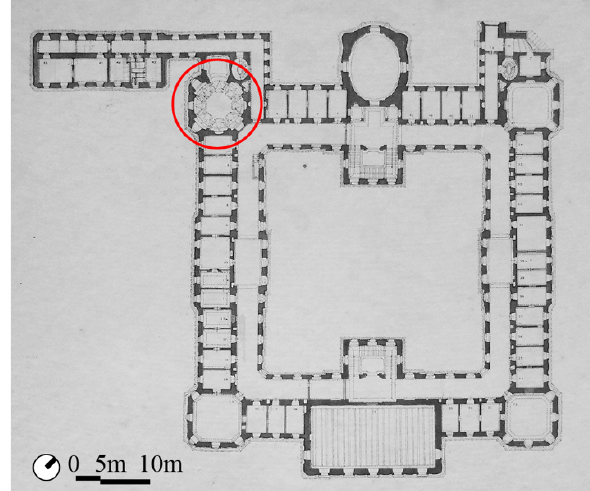
Figure 2. The plan of the Plasy Monastery, in red the